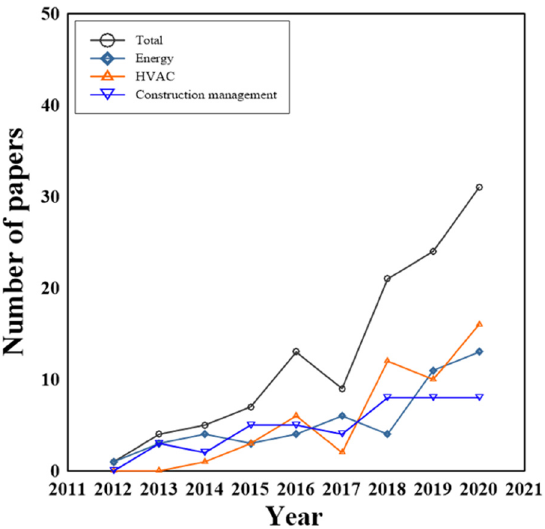
Figure 2. Chronological comparison of research articles using the application of integrated BIM and CFD integration .